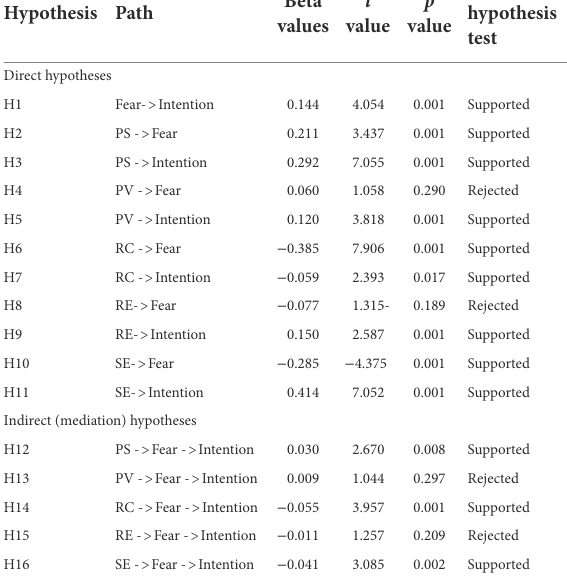
TABLE 6 Summary of testing hypotheses.